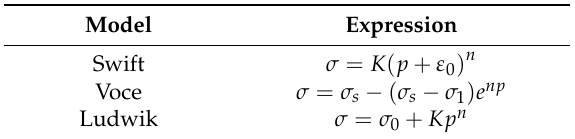
Table 1. Other phenomenological constitutive models.